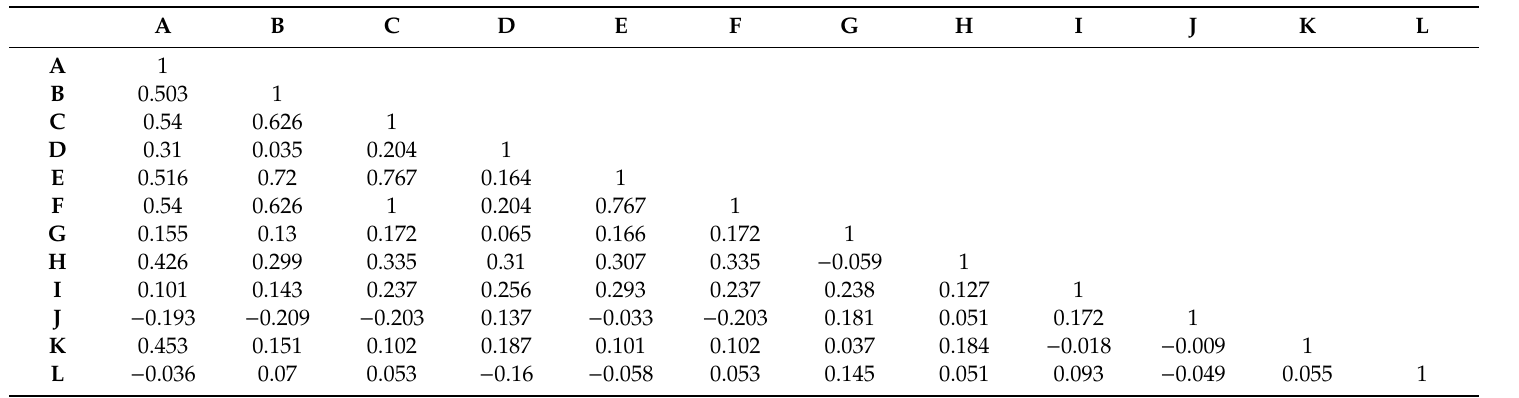
Table 6. Pearson correlation analysis; A-L denotes factors mentioned in Table